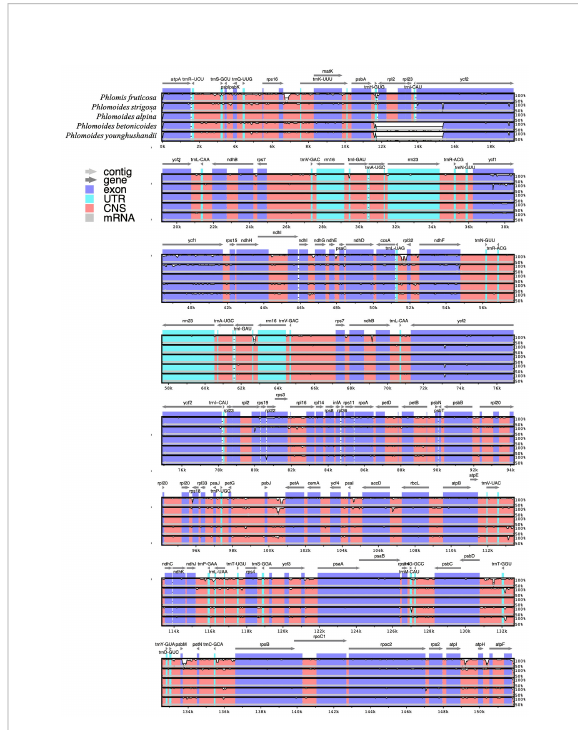
FIGURE 4 Comparison of the chloroplast genomes of Phlomis fruticosa and four Phlomoides species. The mVISTA plot is based on moving a speci fi ed window over the entire alignment and calculating the percent identity over the window at each base pair. The x-axis represents the base sequence, and the y-axis represents the percent identity. Arrows indicate the direction of genes, while the coding exons and UTRs are marked with rectangles of different color. Conserved regions (de fi ned below) are highlighted under the curve, with red indicating a conserved non-coding region and blue indicating a conserved exon. Conserved UTRs are colored turquoise. A conserved regions are de fi ned with percentage and length cutoffs. Conserved segments with percent identity x and length y are de fi ned to be regions in which each contiguous subsegment of length y is at least x% identical to its paired sequence. These segments are merged to de fi ne the conserved regions.